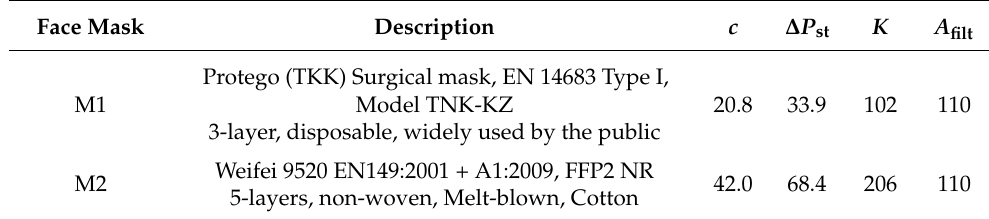
Table 1. Face masks and filter properties. Measured resistance c (Pa per L min − 1 through